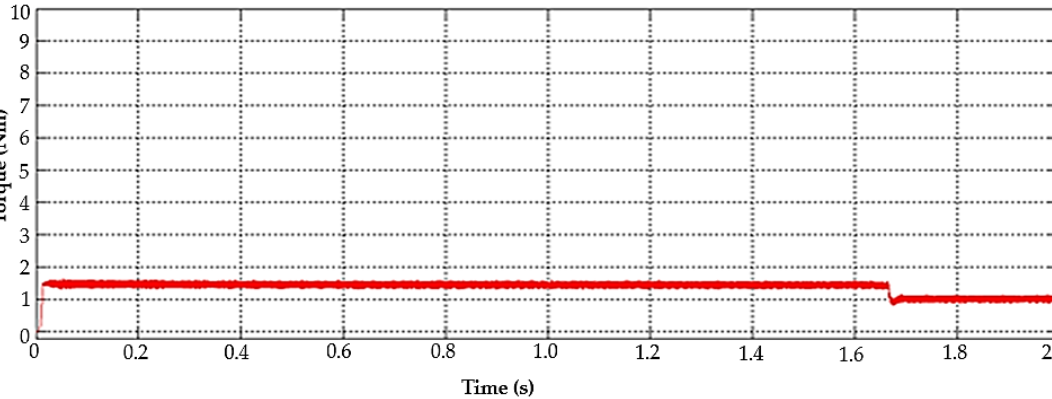
Figure 12. Output load torque characteristics of the BLDC motor after using the LUO converter.